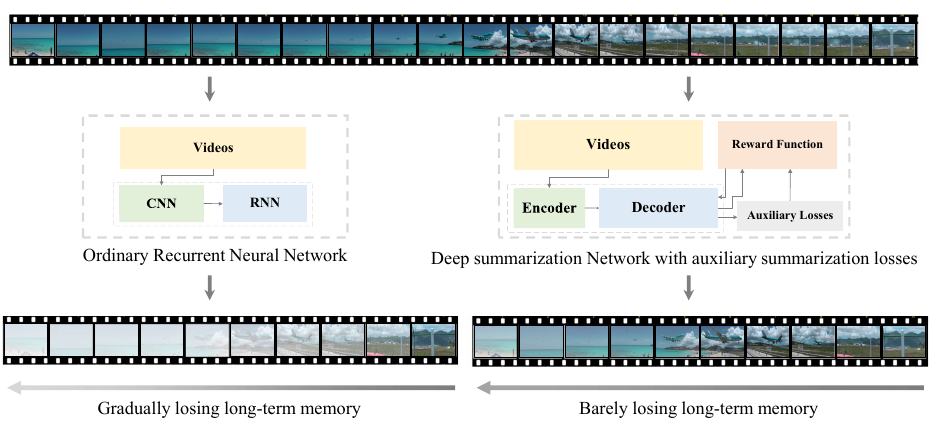
Figure 1. Overview of networks with long-term dependency capture capability (the proposed model) and recurrent neural